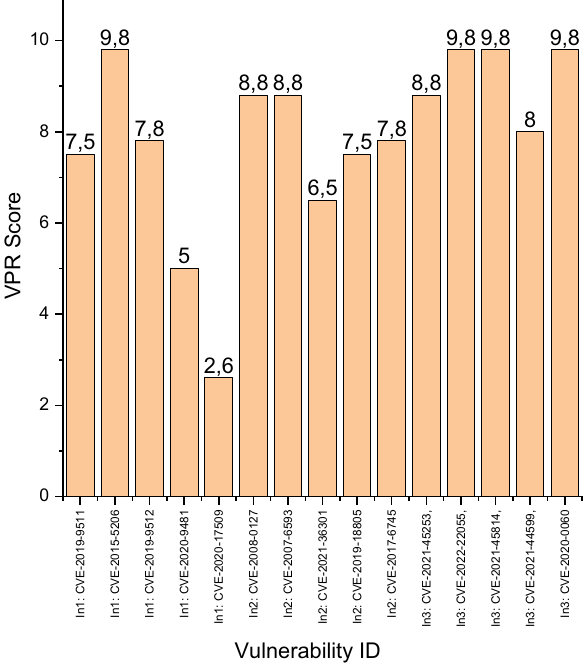
Figure 2. Values of VPR metrics for vulnerabilities mentioned in sets In 1 – In 3